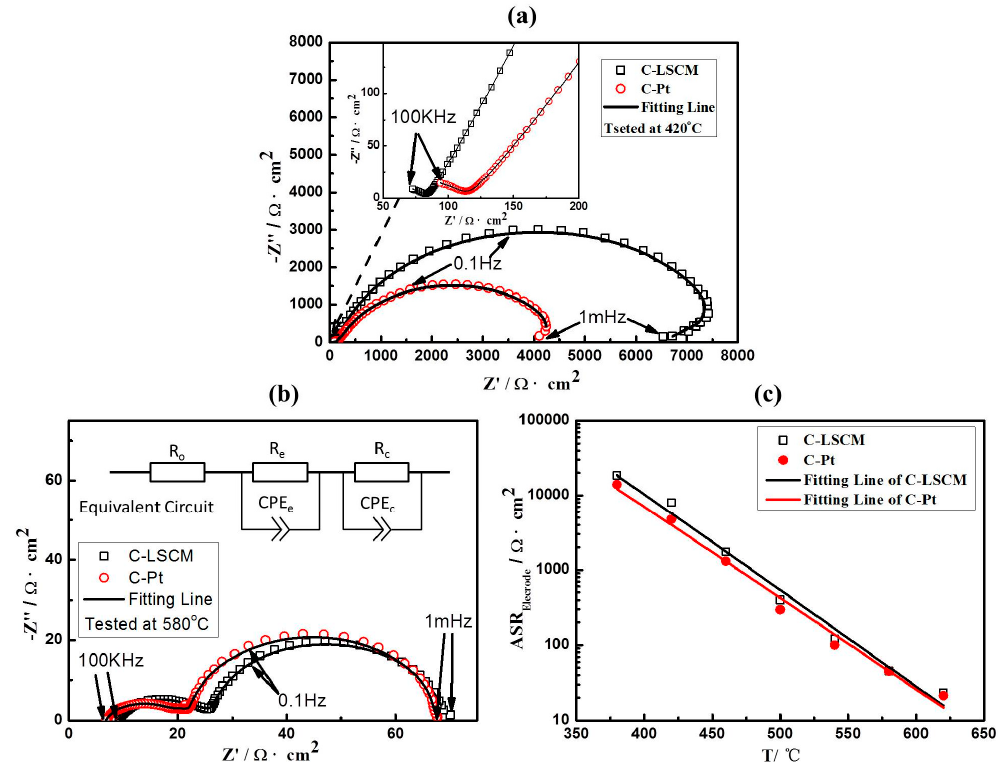
Figure 4. EIS of C-LSCM and C-Pt tested at ( a ) 420 °C and ( b ) 580 °C; and, ( c ) The relationship between area resistance and operating temperature of C-LSCM and C-Pt.